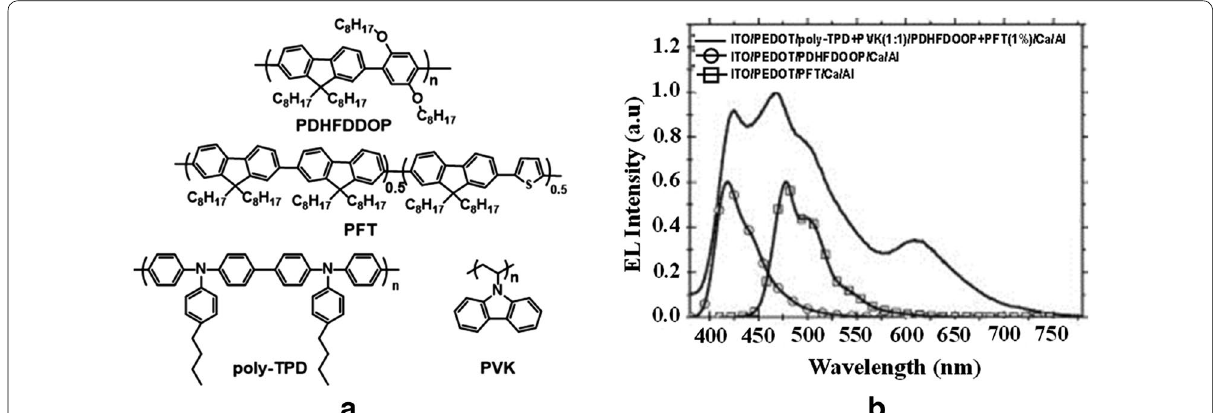
Fig. 7 a Chemical structures of different polymers. b EL spectra of single and double layer PLEDs (Reproduced with permission from [24] Copyright 2006 ©Applied Physics Letters)